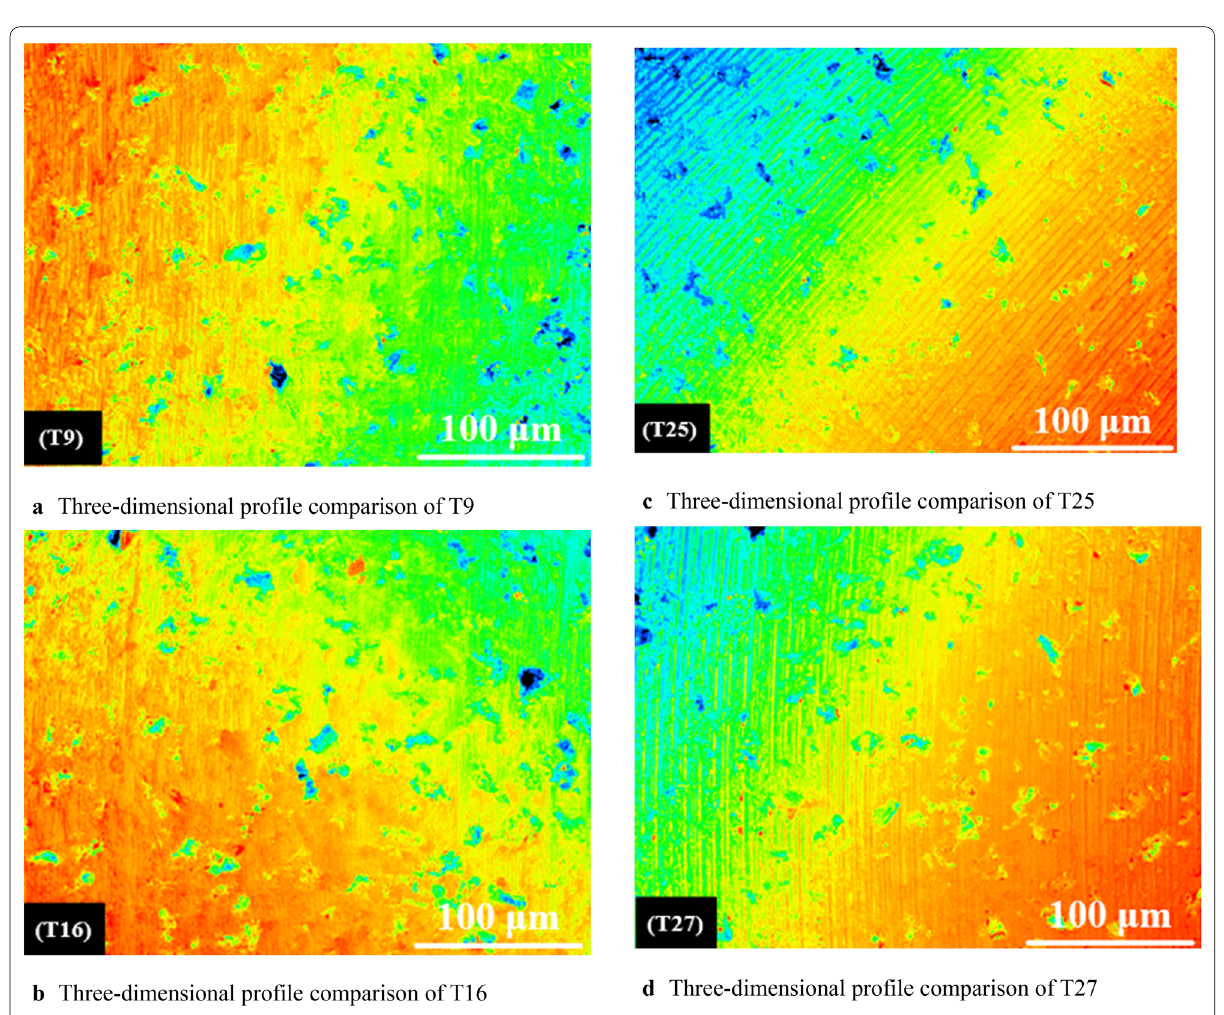
Figure 14 Three-dimensional profile comparison of T9, T16, T25, and